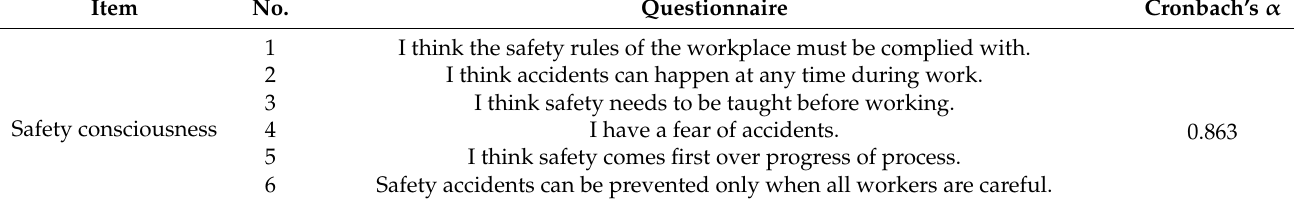
Table 4. Questionnaire for determining safety consciousness and safety commitment of workers. Item